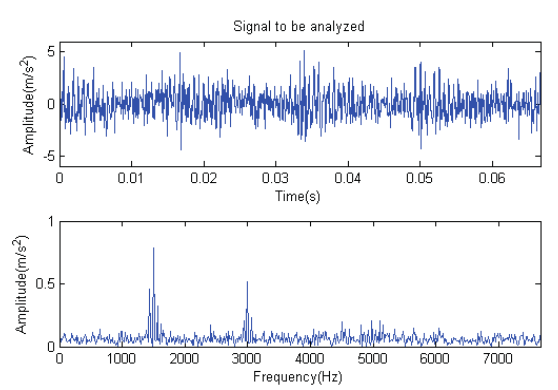
Figure 19. Signal to be